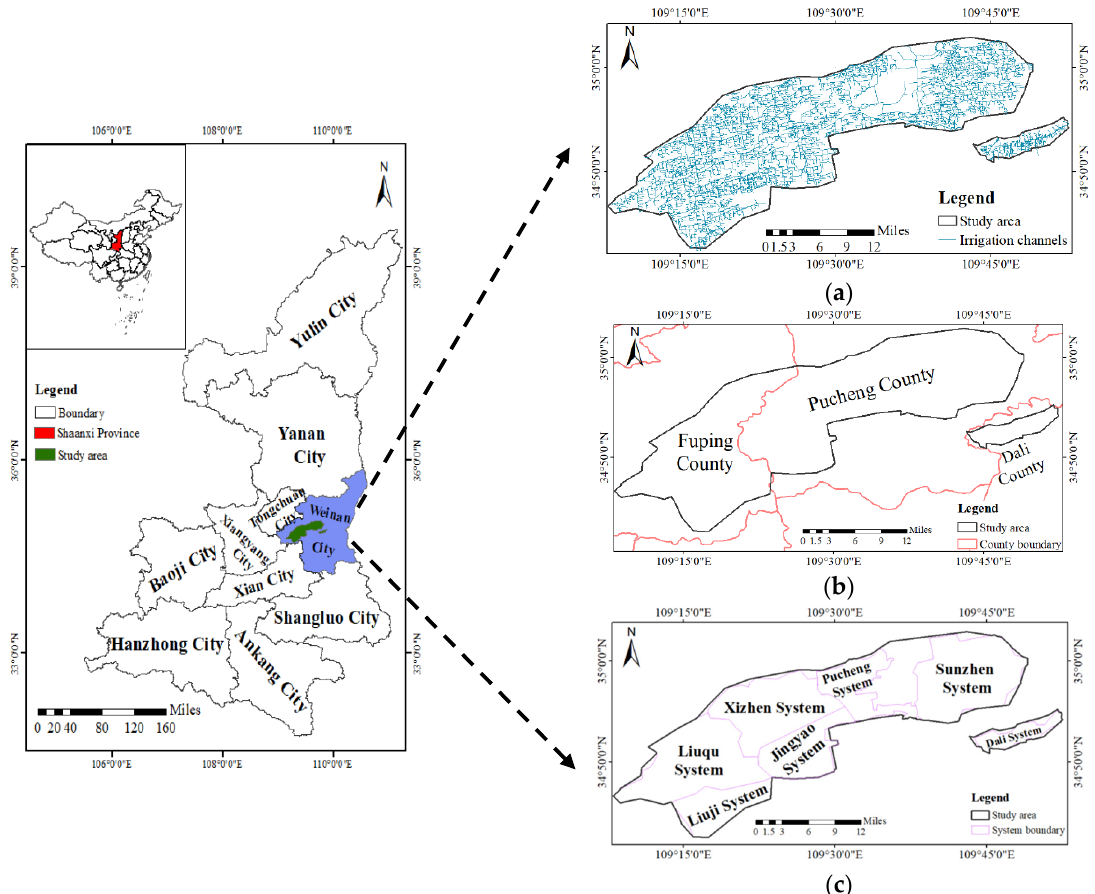
Figure 1. The location of the Donglei Irrigation District (Phase II). ( a ) canal distribution, ( b ) county distribution, ( c ) irrigation system distribution.